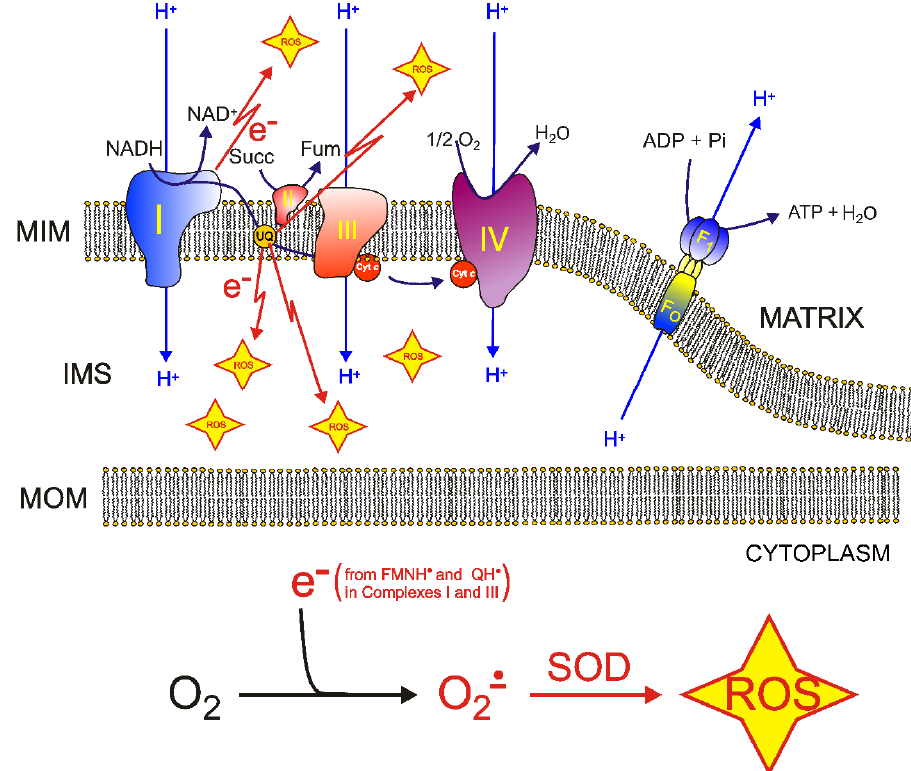
Figure 3. Mitochondrial respiratory chain and sites of superoxide production within mitochondria. Incomplete reduction of O 2 at complex I and complex III during mitochondrial respiration leads to the formation of the superoxide anion. The superoxide anion produced at the level of complex I is released into the mitochondrial matrix. The superoxide anion produced at the level of complex III can be released either to the matrix space or to the intermembrane space. MIM and MOM stand for mitochondrial inner and outer membrane, respectively. IMS stands for intermembrane space. Patients with primary CoQ 10 deficiency and the myopathic variant have clinical man- ifestations affecting both the peripheral and central nervous systems: severe exercise in- tolerance, peripheral neuropathy, seizures, ataxia, pyramidal signs and mental retarda- tion. Muscle biopsies show abundant RRF and increased lipids. Muscle CoQ 10 level is re- duced. Primary CoQ deficiencies may respond to exogenous CoQ 10 administration with a general amelioration of the patient clinical conditions [39,63,86,116,123–127]. CoQ 10 sup-